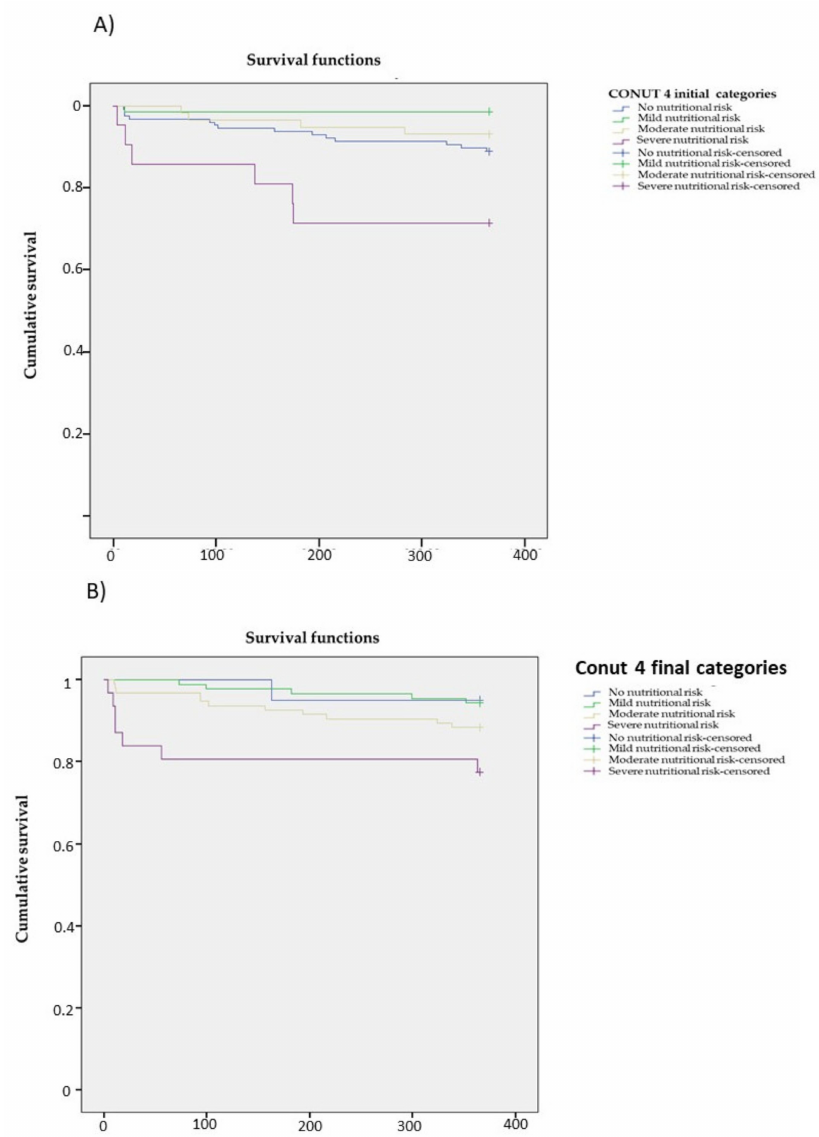
Figure 2. Survival curve using the Kaplan-Meier analysis based on the nutritional status estimated by CONUT. ( A ) Survival curve with the nutritional estimate using CONUT at hospital admission. (B) Analysis with the nutritional estimate using CONUT at hospital